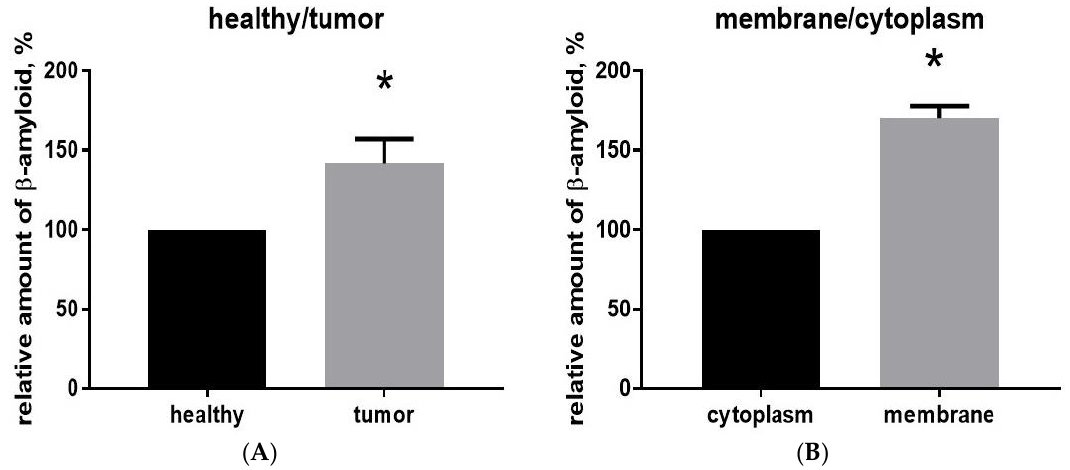
Figure 2. ( A ) The relative amount of A β 40 in the glioma tissue is elevated. ( B ) A β 40 in glioma tumor tissue is concentrated in the cell membrane fraction.